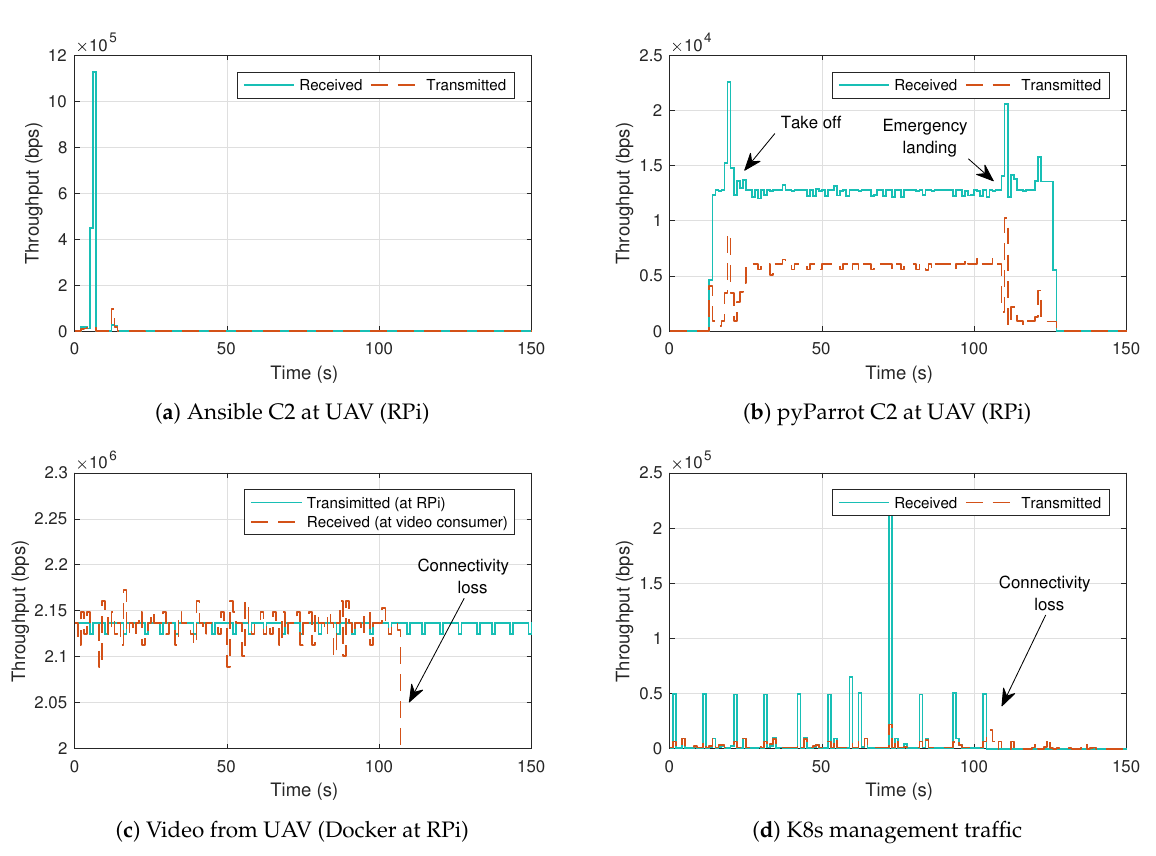
Figure 7. Measurements in indoor flight with connectivity